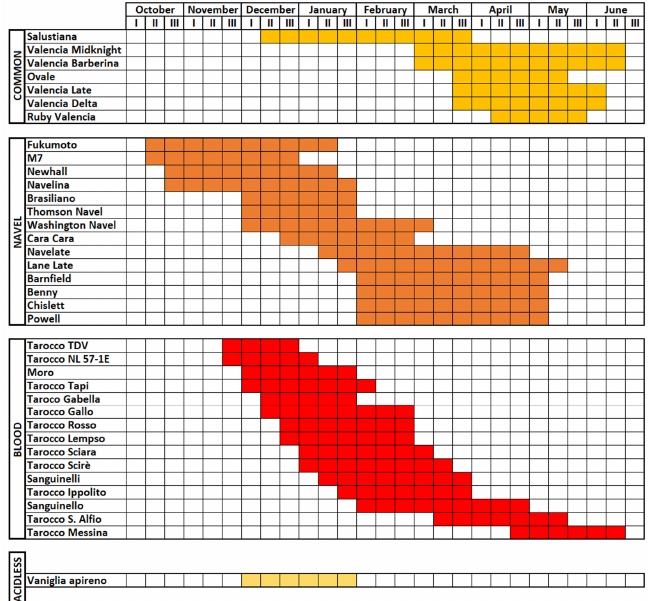
Figure 3. Ripening period of some of the most diffuse varieties in the Mediterranean area (orange color:sweet orange common subgroup; dark orange: navel subgroup; red color: blood subgroup; pale orange: acidless subgroup).Their variability strongly depends on their cultivation environments and rootstock influence.